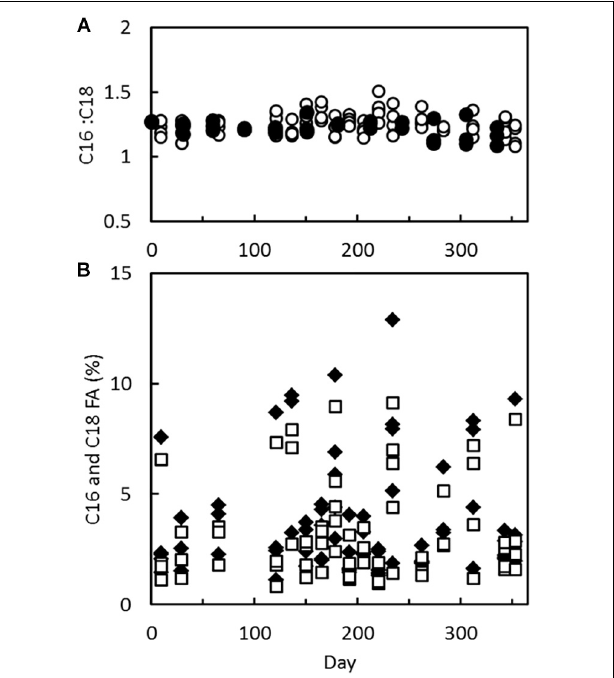
FIGURE 3 | Halichondria panicea and H. bowerbanki . (A) Ratio of palmitic acid and stearic acid, C16:C18 in H. panicea from the inlet to